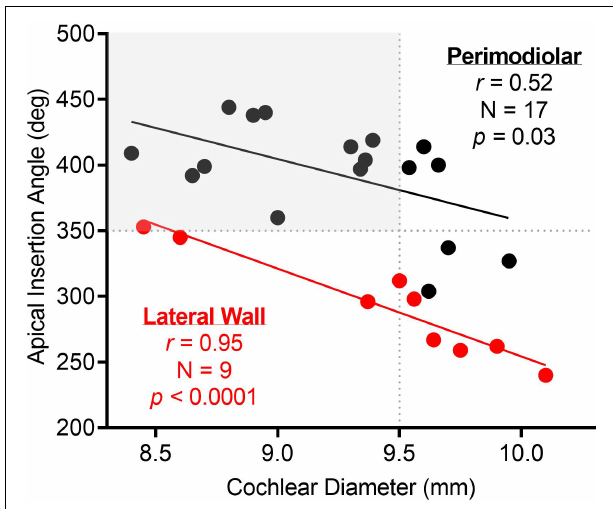
FIGURE 7 | There was a strong linear correlation between apical insertion angle and cochlear diameter for both perimodiolar and lateral wall electrodes. The dotted lines highlight the apical insertion angle and cochlear diameter where the electrode sweep results in a maximum amplitude CM at a more basal electrode than the most-apical one for 500-Hz stimulus frequency. As highlighted in gray, a cochlear diameter less than 9.5 mm and an apical insertion angle greater than 350 degrees may result in the most-apical electrode crossing the CF place for